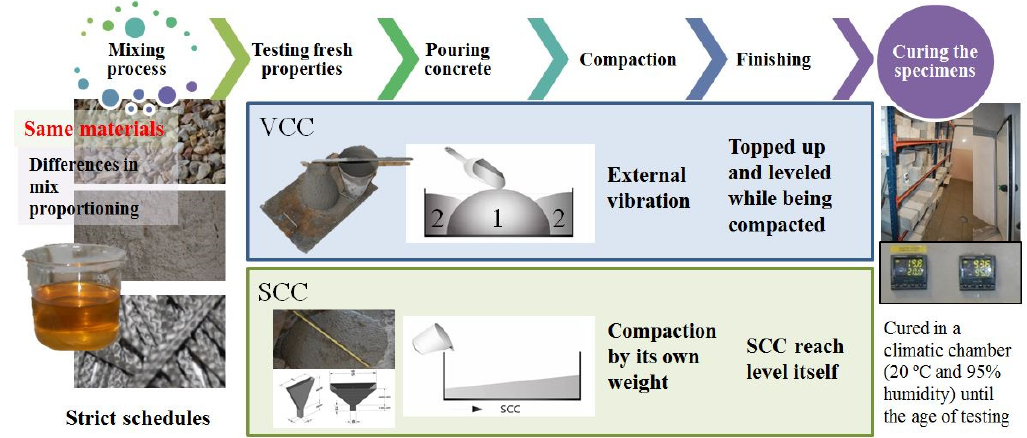
Figure 3. Main processes of SCC and VCC concrete